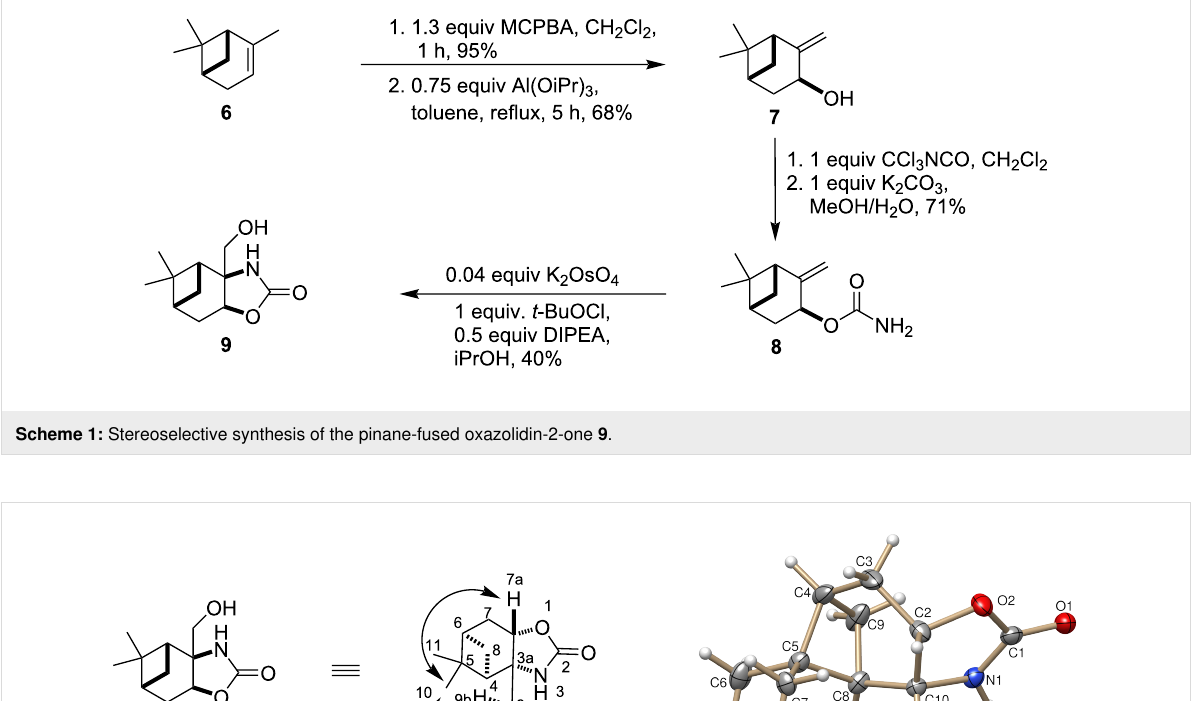
Figure 2: NOESY experiments and X-ray structure elucidation of oxazolidin-2-one 9 .